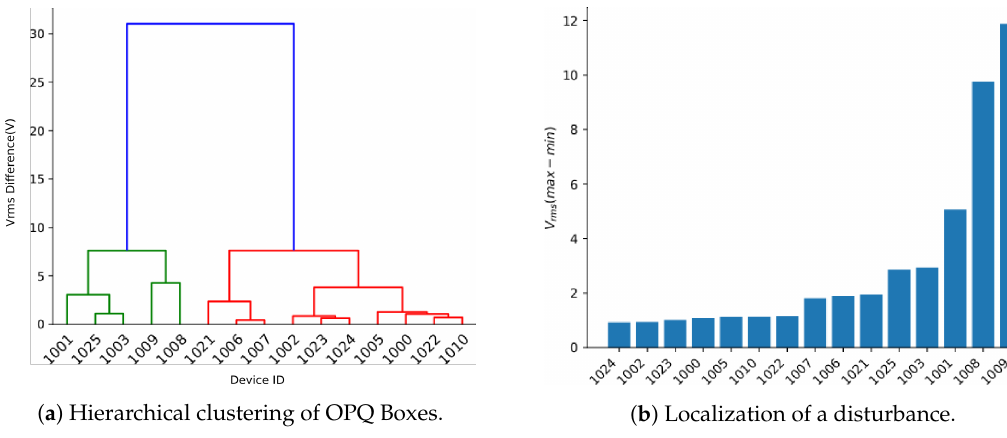
Figure 12. Hierarchical clustering of OPQ Boxes, and localization of a